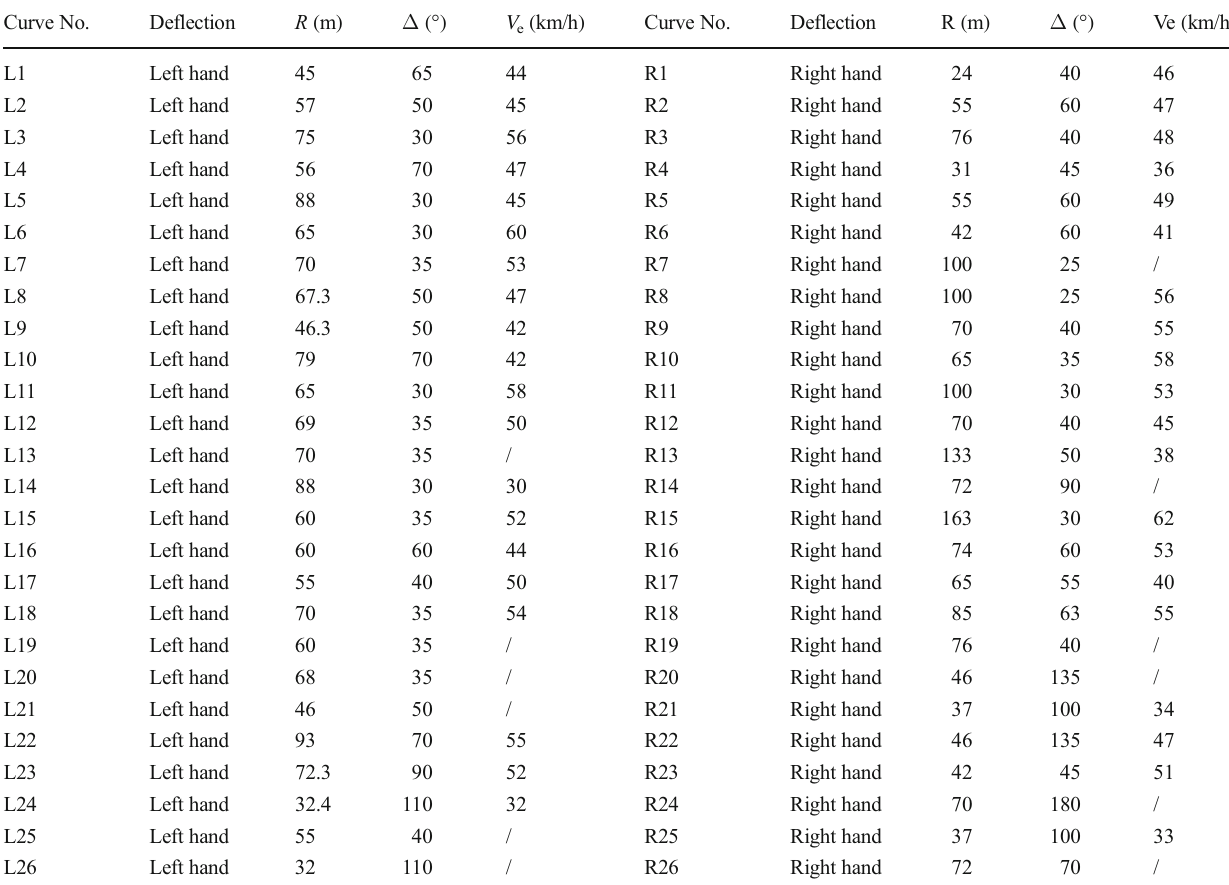
Table 3 Geometric parameters of the curves used in Section 3.1 and 3.2 Curve